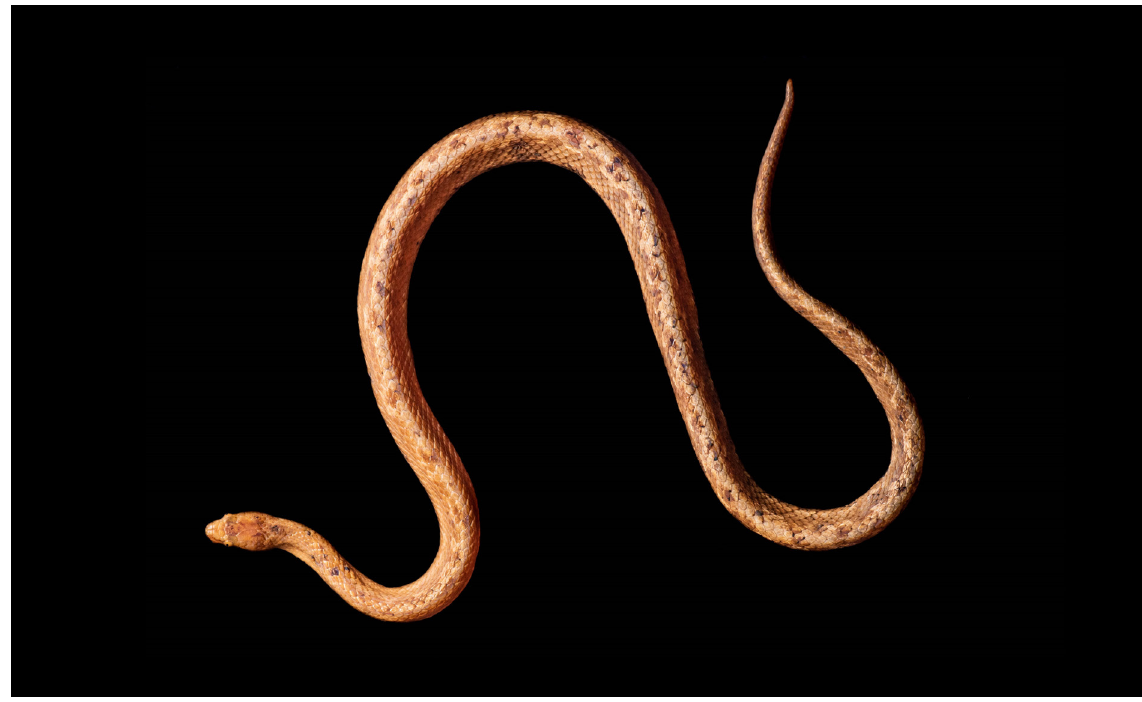
Fig. 6. Dorsal view of Tropidophis cacuangoae sp. nov., ♀, paratype (DHMECN 15893) in life. Photograph credits: Danilo